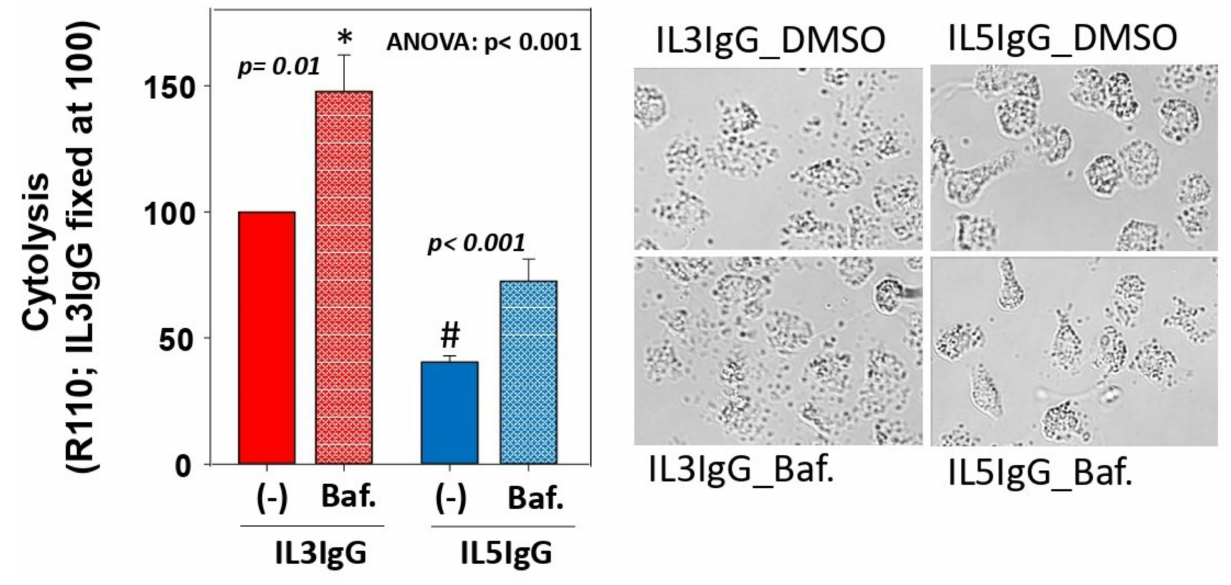
Figure 4. Inhibition of the formation of autophagolysosomes leads to increased eosinophil cytolysis on IgG. Eosinophils were primed with either IL3 (2 ng/mL) or IL5 (2 ng/mL) for 20 h, treated with bafilomycin-A1 (Baf.; 1 µ M) or vehicle only [(-); DMSO] for 20 min, and seeded on HA-IgG for 4.5 h before addition of R110 for 30 min. Cytolysis was measured by fluorescence (485 nm Ex /520 nm Em ). Values obtained with the controls (medium only and IL3-primed eosinophils seeded without IgG) were subtracted from the values obtained for cytokine-primed eosinophils on IgG (IL3IgG and IL5IgG). For each of the 4 experiments (4 different blood donors), the value for IL3IgG was fixed at 100. After Log10 transformation, one-way ANOVA followed by Holm-Sidak was performed and p values comparing Baf. versus no Baf. are shown. # indicates p < 0.001 between (-)IL3IgG and (-)IL5IgG, and * indicates p < 0.001 between Baf.IL3IgG and Baf.IL5IgG. A representative image of the